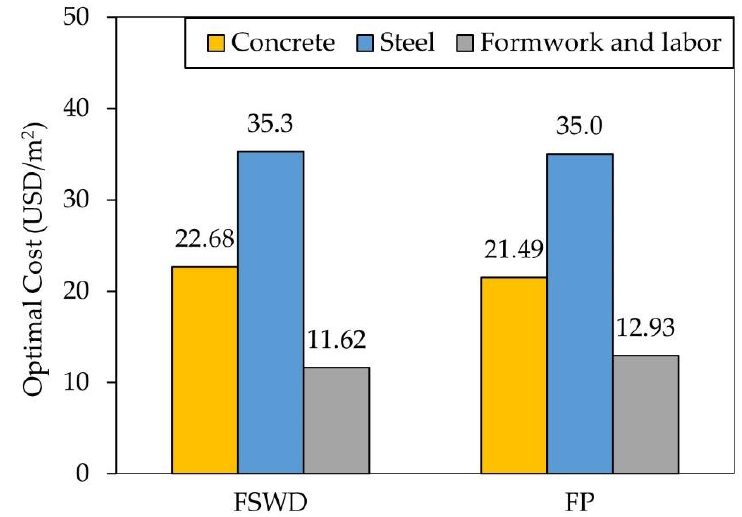
Figure 15. Distribution of materials and labor costs for the best design alternatives.